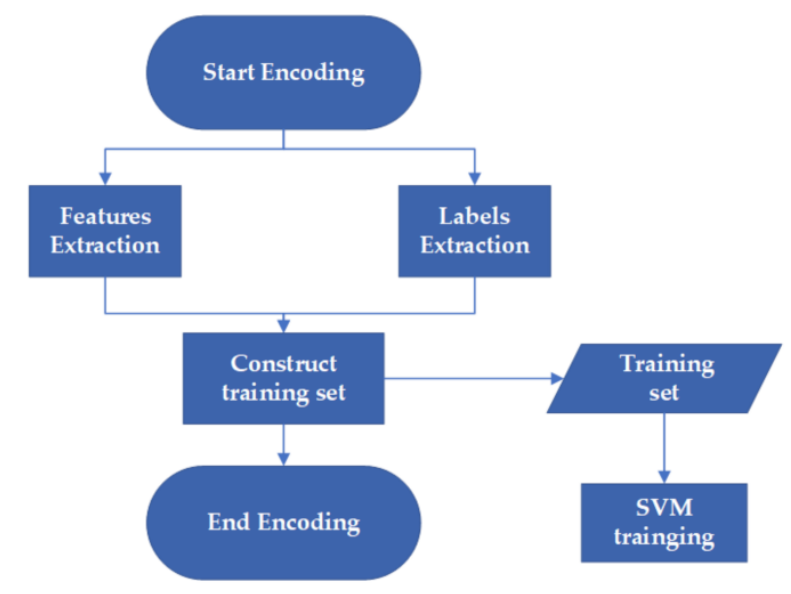
Figure 4. The flowchart of training SVM